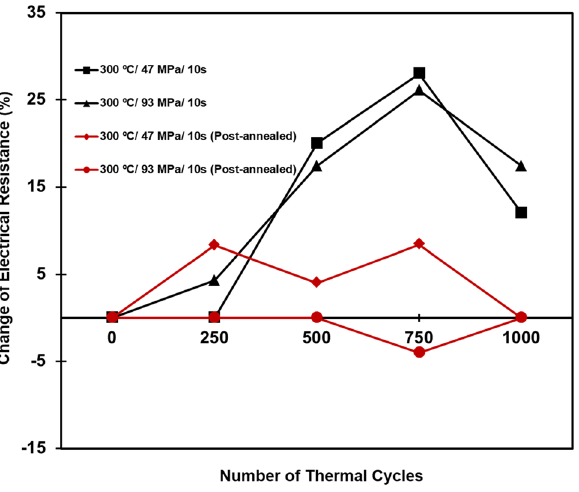
Figure 6. Changes in electrical resistance of the joints bonded at different conditions. The electrical resistance of the post-annealed joints remained almost unchanged after 1000 thermal cycles.